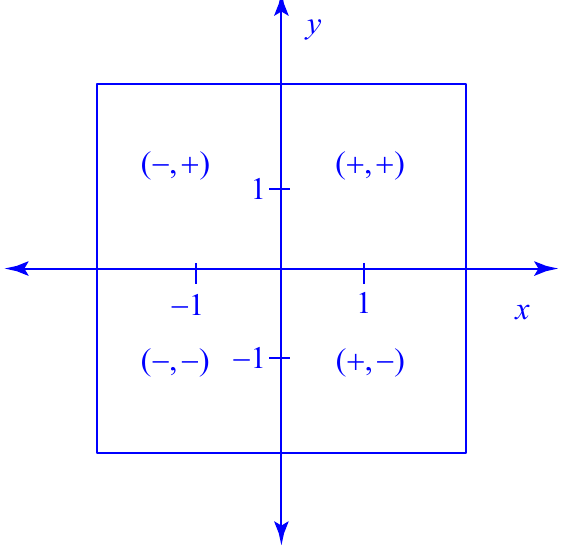
Figure 2: The ontic state space of Spekkens toy-bit. The ontic states are labeled ( x , y ) where x and y take values ± 1 , which are abbreviated to ± for compactness.